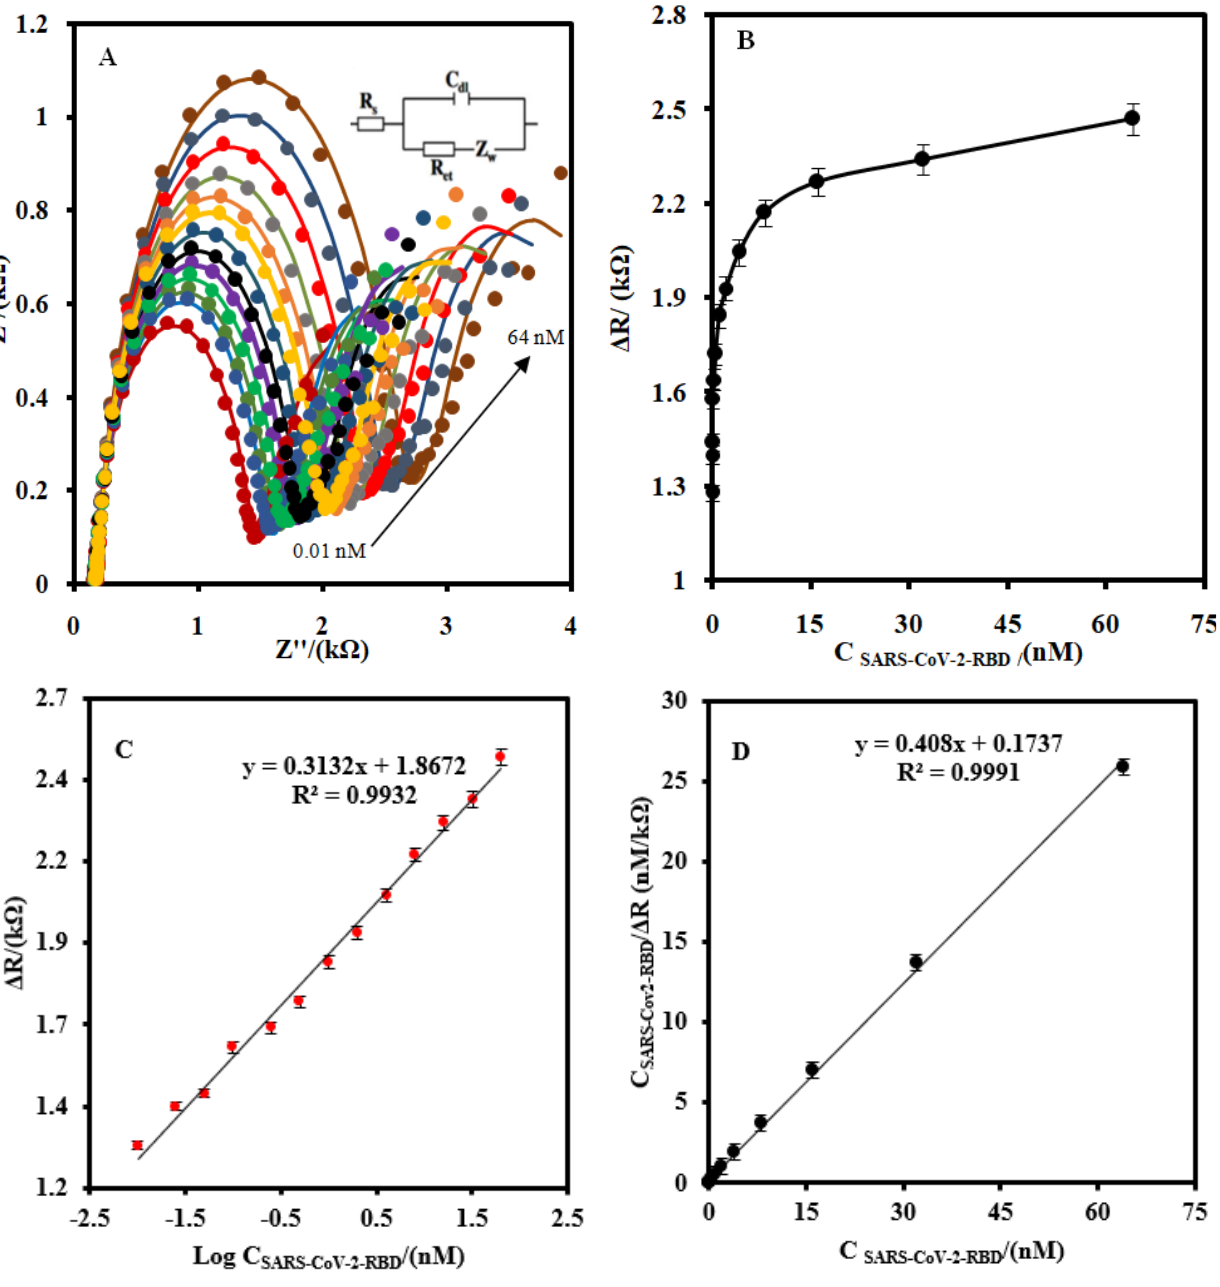
Figure 4. (A ) The EIS of the CSPE/CNF–AuNP/Aptamer at the optimum operating conditions for different concentration of SARS-CoV-2-RBD (0.01, 0.025, 0.05, 0.1, 0.25, 0.5, 1.0, 2, 4, 8, 16, 32, and 64 nM) at 5.0 mM Fe(CN) 63 − /4 − solution (0.1 M PBS, pH 7.4). ( B ) The linear–linear and ( C ) line- ar – logarithmic calibration curve plots . ( D ) The plot of the Langmuir binding isotherm model. The equivalent electric circuit is compatible with the Nyquist diagrams. R s : Solution resistance; R ct : charge transfer resistance; C dl : Double layer capacitance; Z w : Warburg impedance. The AC ampli- tude voltage was 10 mV, DC voltage was 0.13 V, and the frequency range was 100 kHz–0.1 Hz. The error bars were obtained by using four different aptasensors.